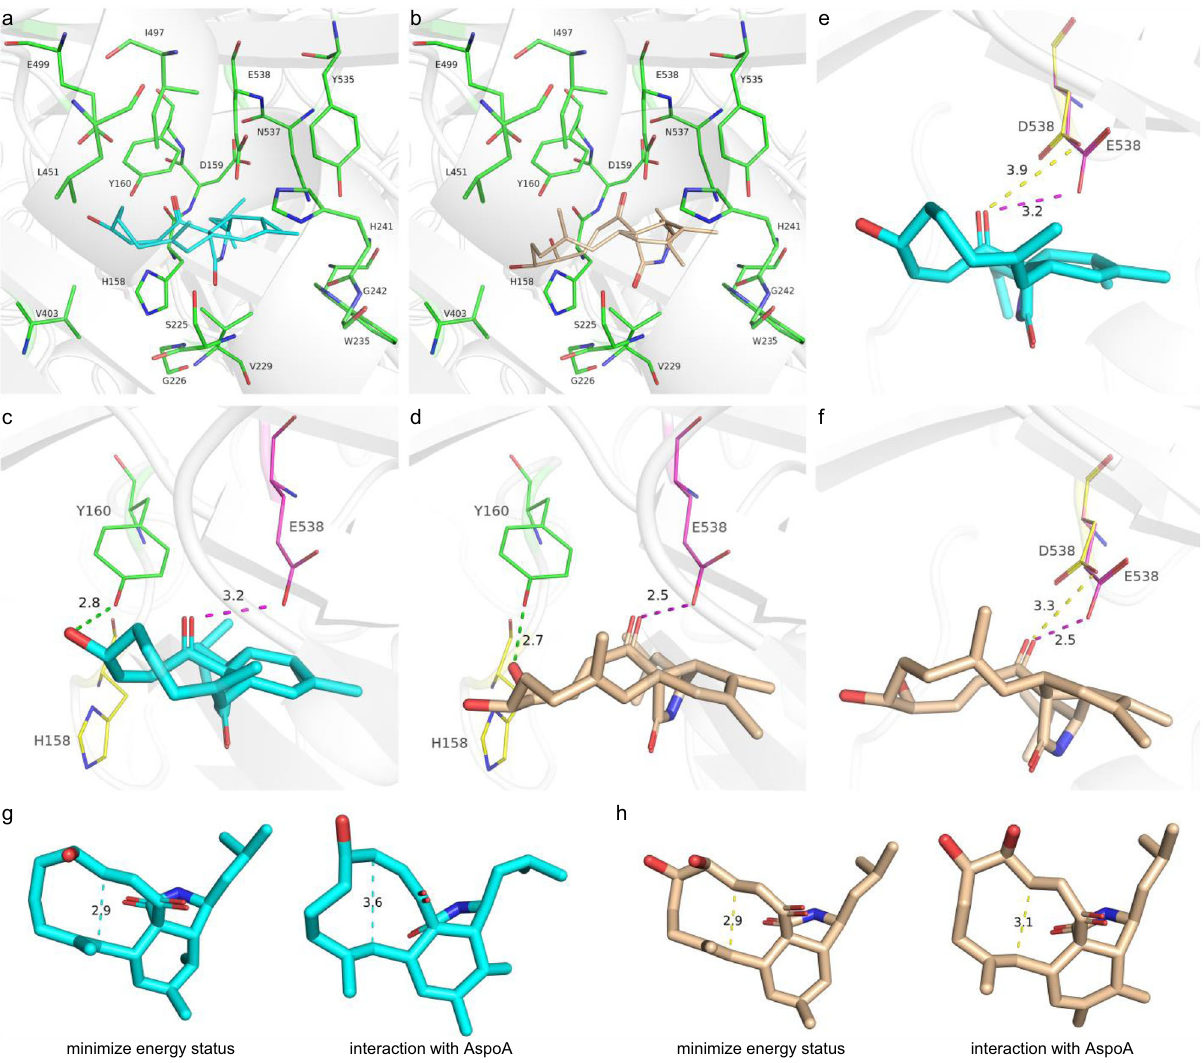
Fig. 6 Molecular docking model of AspoA with substrates 7 and 8. The proposed complex structures of AspoA with 7 ( a ) and 8 ( b ). The proposed distance between AspoA-Glu 538 and the C 21 carbonyl group of 7 ( c ) and 8 ( d ), or the AspoA-Tyr 160 and C 18 hydroxy group of 7 ( c ) and 8 ( d ). The proposed distance between AspoA-Glu 538 or AspoA mutant Asp 538 and C 21 carbonyl group of 7 ( e ) and 8 ( f ). The proposed distance between C 13 and C 19 of 7 ( g ) and 8 ( h ) in minimize energy status (left) or in interaction with AspoA status (right). Compounds 7 and 8 are shown in cyan and wheat